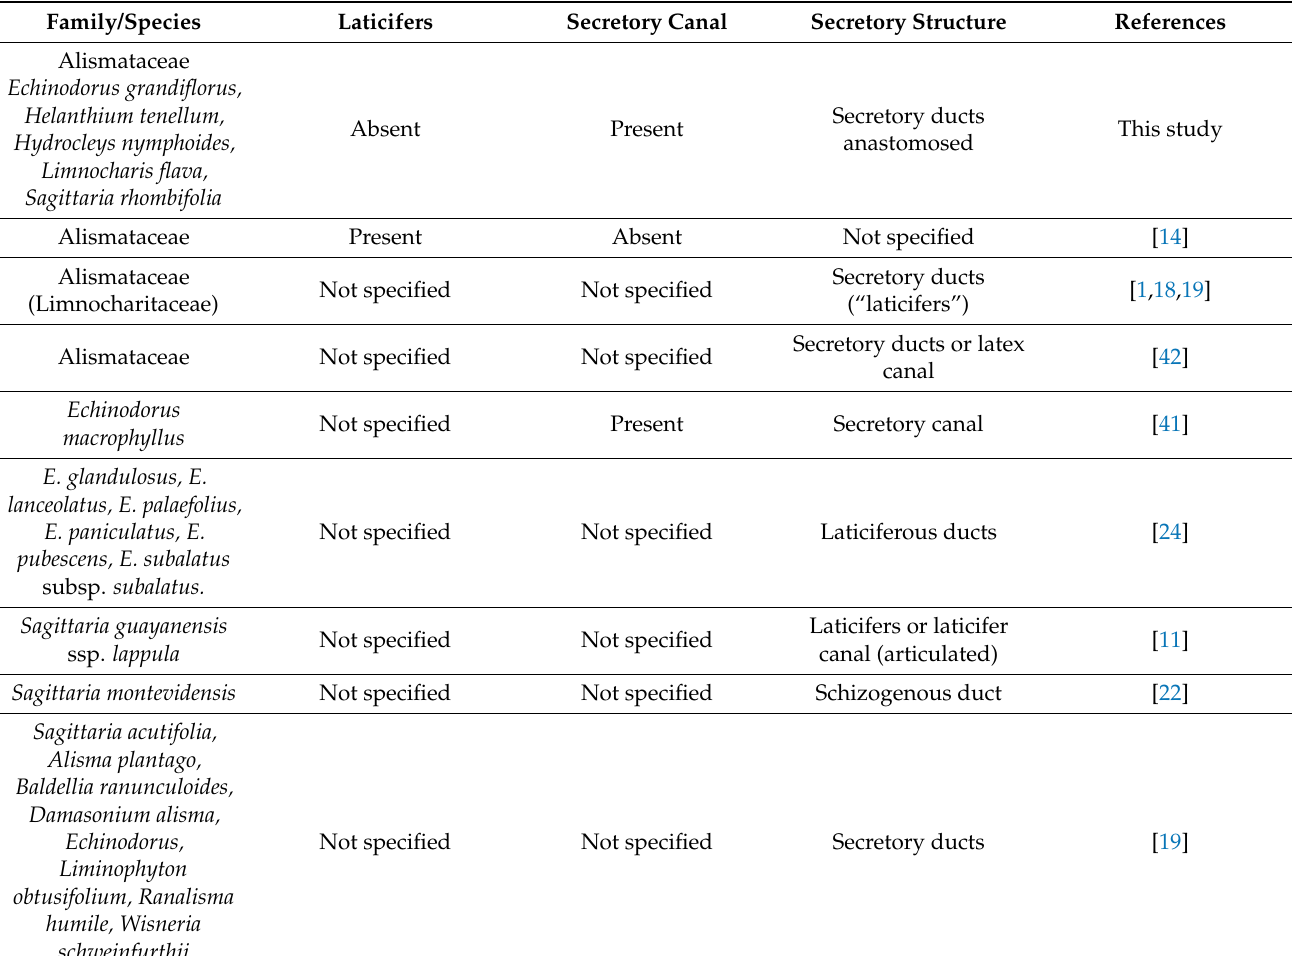
Table 3. Survey of secretory structures in Alismatales based on the specialized